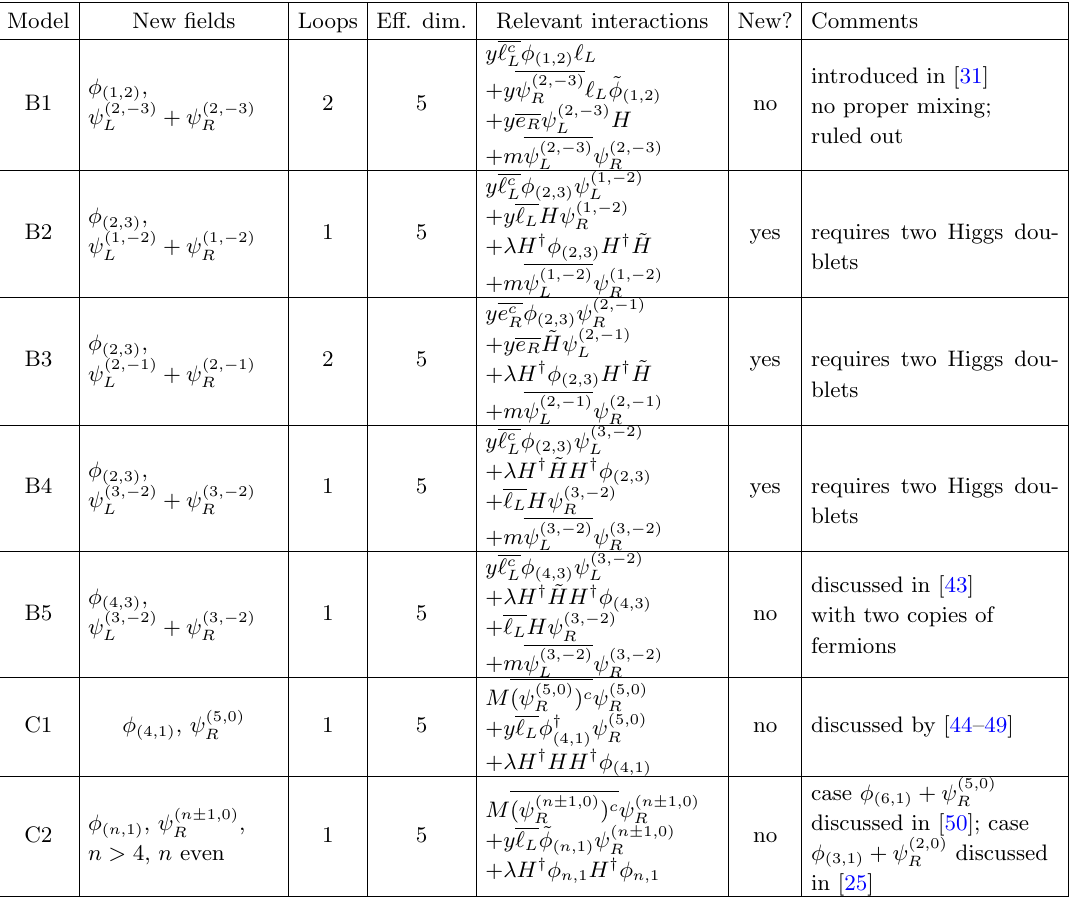
Table 3 . Radiative neutrino mass models with one scalar and one fermion without